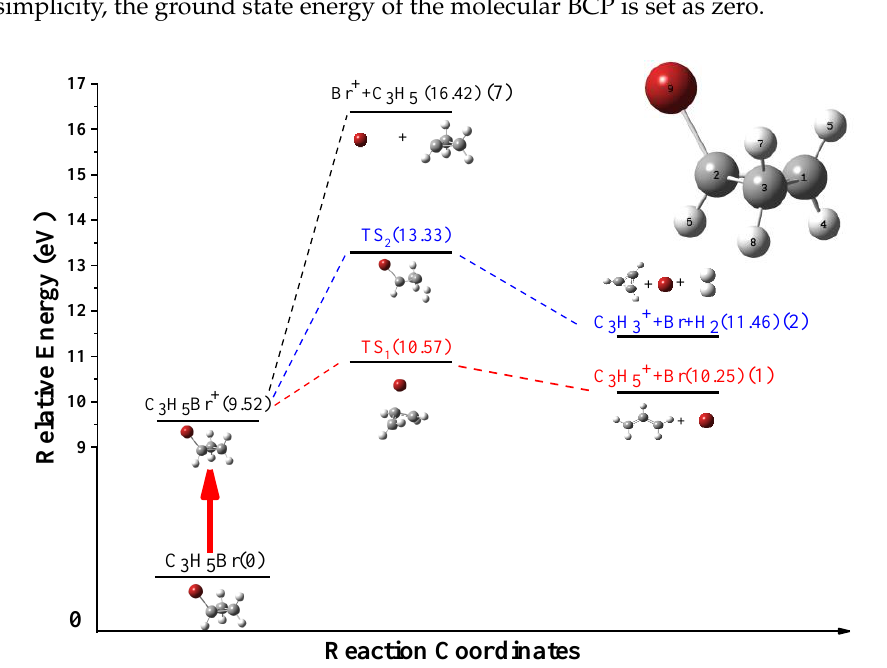
Figure 4. The dissociation pathways of the singly charged molecular ion BCP + . The calculation is performed at G4 level by Gaussian 16 program.